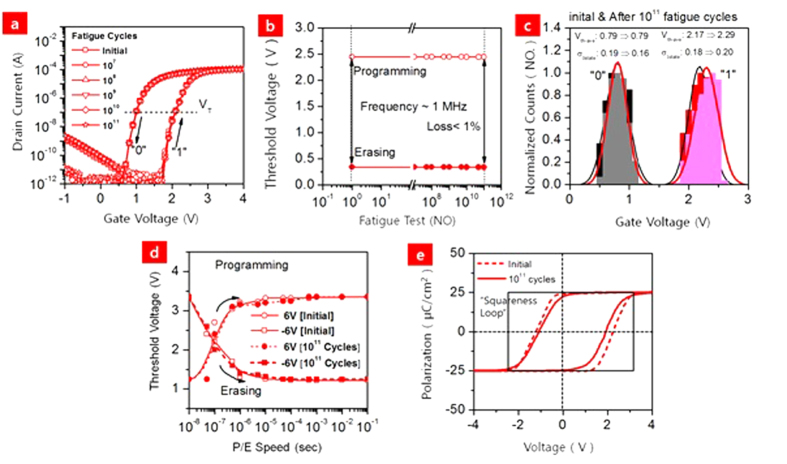
Fatigue effect on the electrical properties of SNLC-PZT FeFET.(a) Transfer curves after various fatigue cycle tests at 0.1 V of drain voltage. Note that the device dimension was W/L = 3.5/2 μm. (b) Fatigue Test respect to the threshold voltage at frequency 1 MHz. (c) Distribution of threshold voltage in erase and program state at initial and after 1011 fatigue cycles.